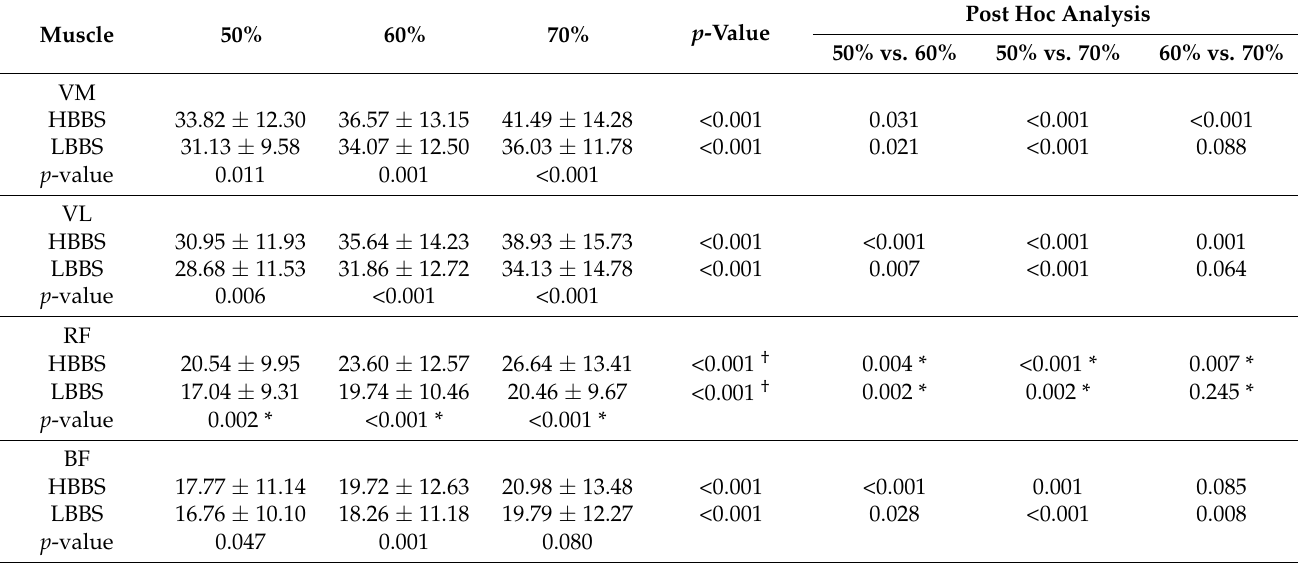
Table 2. Comparison of the muscle activity of the lower extremity during the eccentric